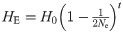
Plot of expected heterozygosity (H
E) against generation number (t).The curved dotted strain indicates theoretical reduction of heterozygosity via single brother-sister matings for every generation, calculated from the following equation: HE=H0(1−12Ne)t, where H
0 is the heterozygosity of the founder colony, and Ne is effective population size (i.e., number of individuals that contribute to breeding). H
E of F0 of N (Gurdon Inst.) (0.509) and 2 are used for H
0 and Ne, respectively. Open rectangles indicate mean H
E estimated from individual based simulation using VORTEX version 10 [43]. During simulation, allele frequencies of N (Gurdon Inst.) were used as initial allele frequency, and single brother-sister mating was conducted in every generation. The simulation was repeated one hundred times. Bar indicates standard deviation.